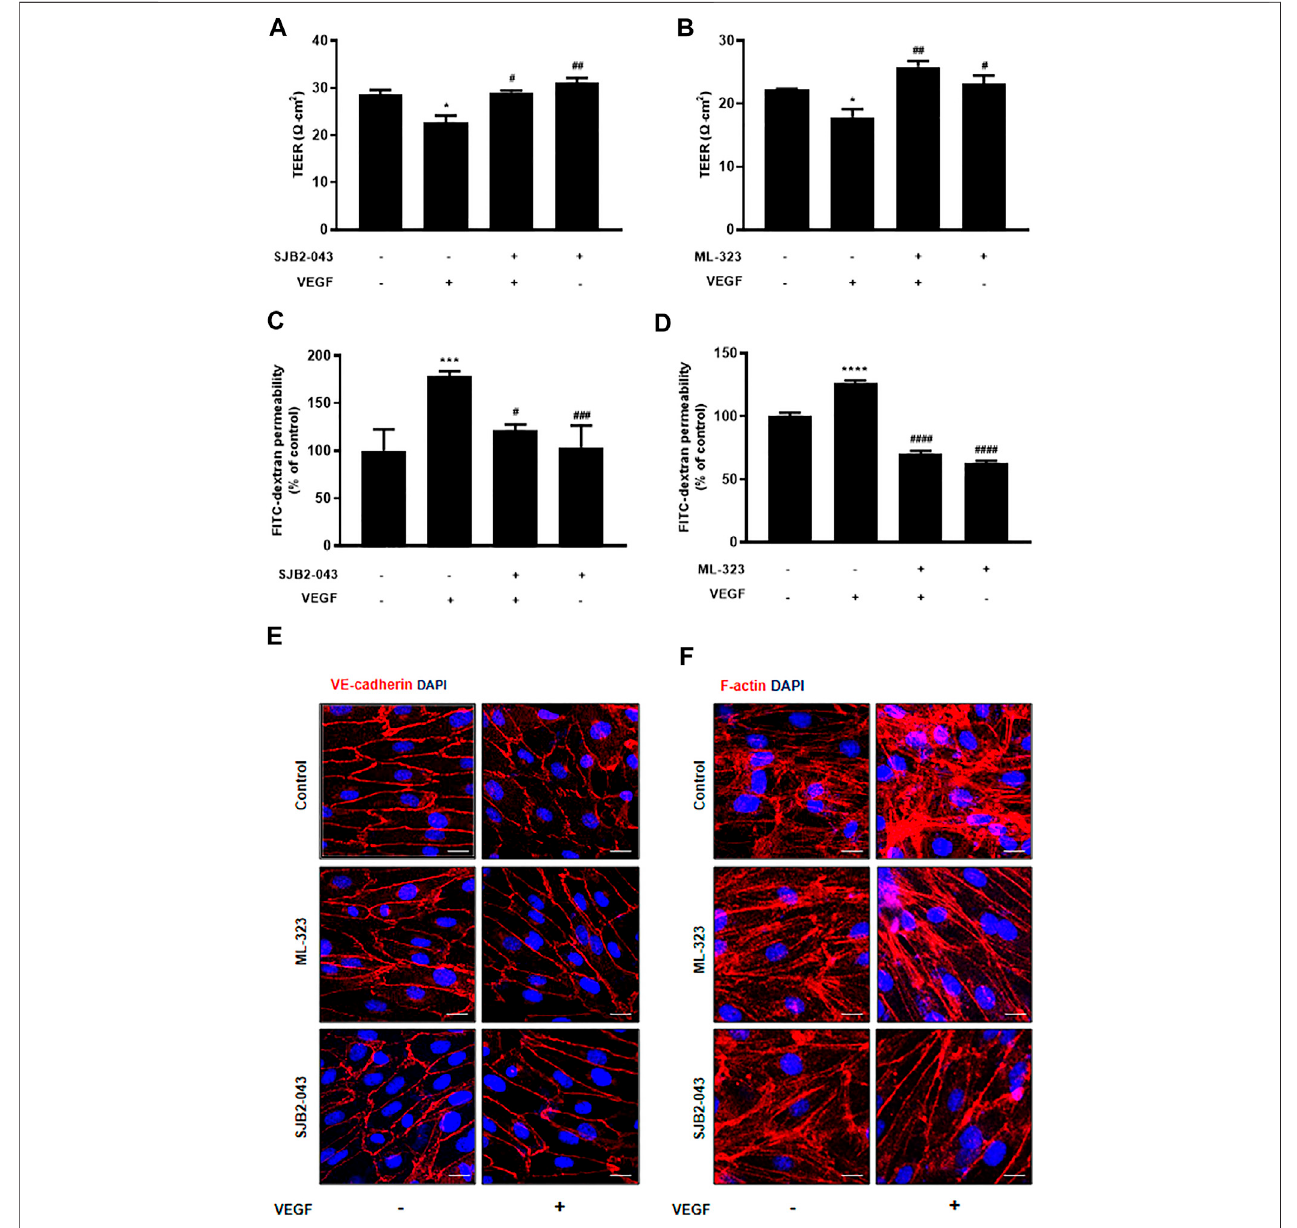
FIGURE 6 | USP1 inhibitor blocks VEGF-induced endothelial permeability and stabilizes junctional proteins. HUVECs were starved and treated with SJB2-043 (1 μ M, 30 min) and ML-323 (5 μ M, 30 min) before stimulation with VEGF (30 ng/ml, 30 min). SJB2-043 and ML-323 blocked both the TEER decline (A,B) (Experiments were performed in triplicate) and the increase in FITC-dextran transendothelial permeability (C,D) (Combined data from the six independent experiments are shown) induced by VEGF. HUVECs were treated with SJB2-043 (1 μ M, 30 min) and ML-323 (5 μ M, 30 min) before stimulation with VEGF (50 ng/ml, 30 min). Cells were fi xed, permeabilized, and subsequently immunostained for VE-cadherin (E) and F-actin (F) All data are presented as means ± SEM, * p < 0.05, *** p < 0.0005, **** p < 0.0001 vs control group; # p < 0.05, ## p < 0.005, ### p < 0.0005, #### p < 0.0001 vs VEGF treated group. Scale bar (cid:2) 20 μ M.